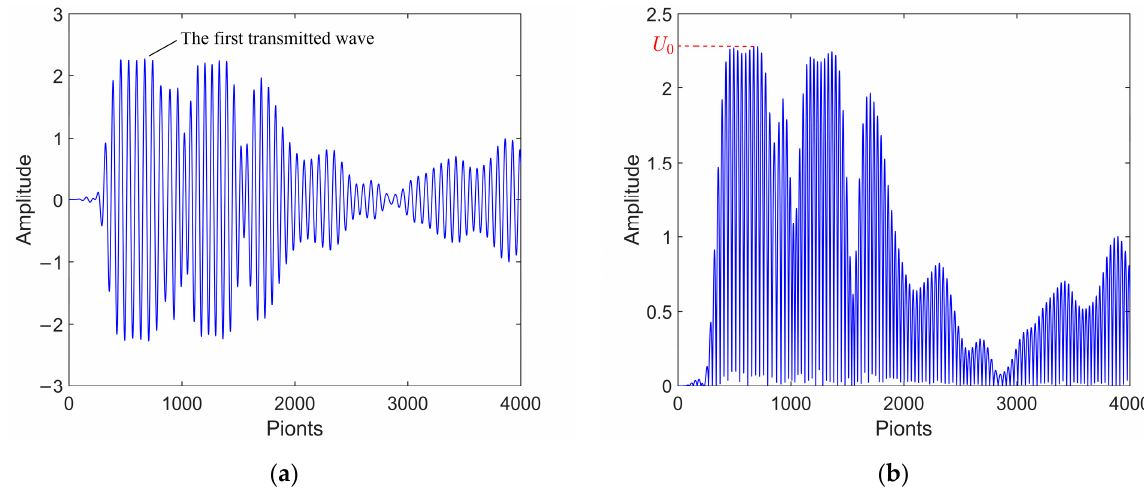
Figure 5. Aluminum block transmission wave data. ( a ) The original data; ( b ) the absolute value data.